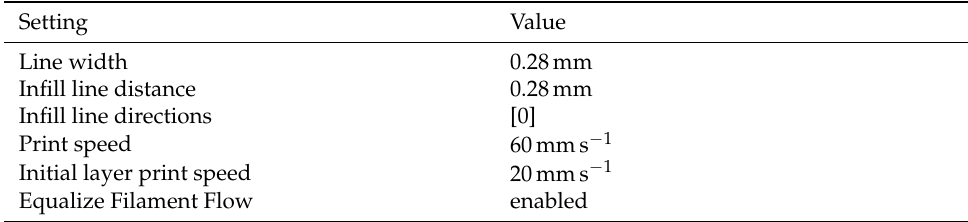
Table 10. Slicer settings 90° orientation.